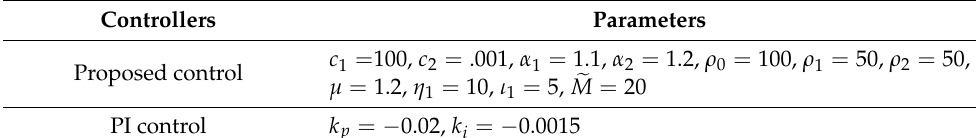
Table 2. Controller parameters.